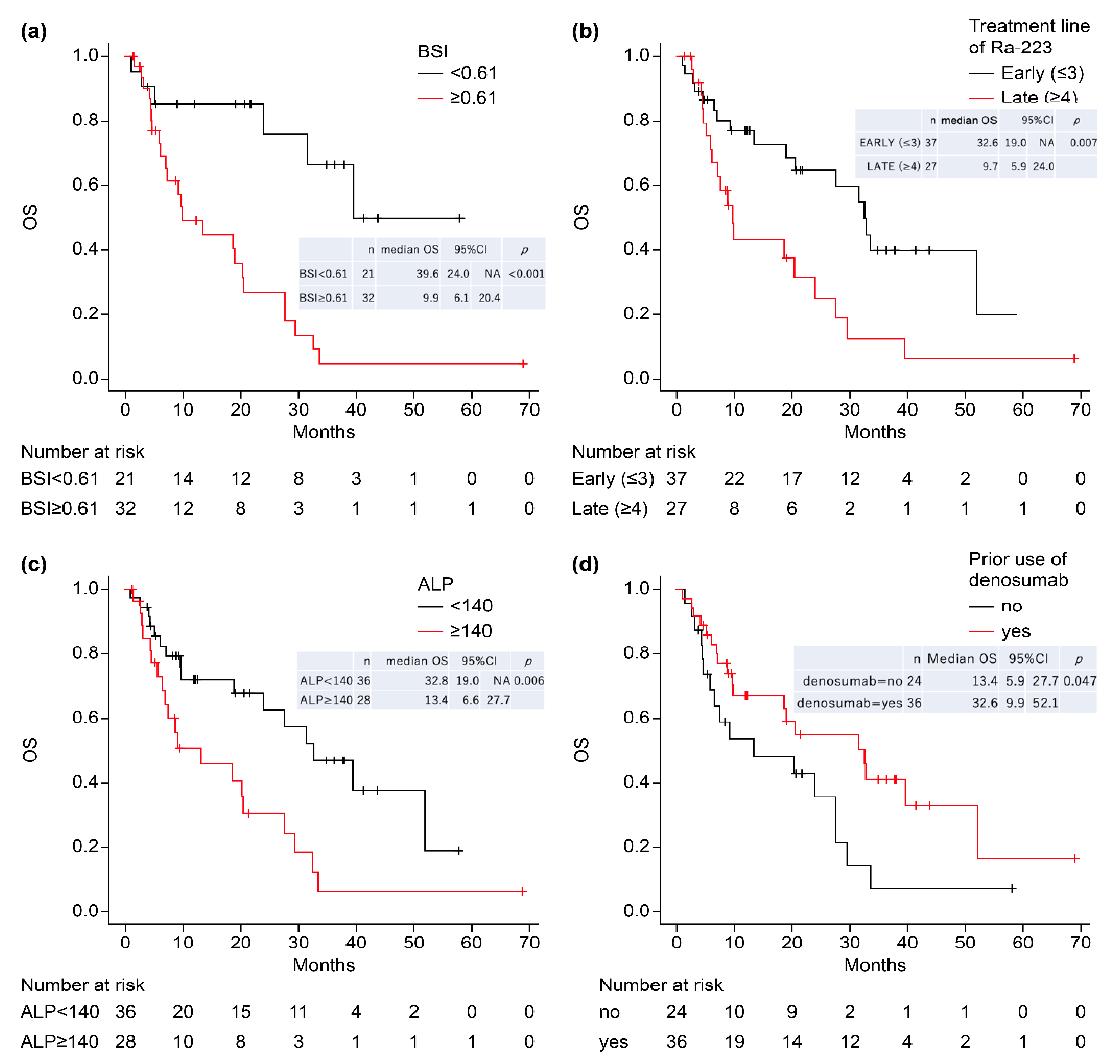
Figure 2. Log-rank test of OS comparison: ( a ) BSI<0.61 vs. BSI ≥ 0.61; ( b ) treatment line of Ra-223, Early ( ≤ 3) vs. Late ( ≥ 4); ( c ) ALP < 140 vs. ALP ≥ 140; ( d ) prior use of denosumab, no vs. yes. Median OS was significantly longer in patients with baseline BSI of <0.61, early treatment ( ≤ 3rd line), baseline ALP of <140U/l, and prior use of denosumab. OS: overall survival. NA: not available. Table 4. Comparison between 2 groups of treatment line (Early vs. Late) (MWU